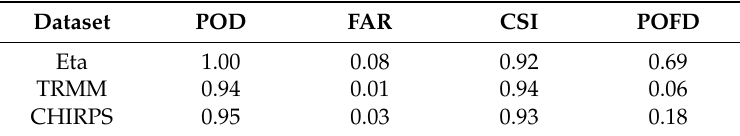
Table 5. Probability of Detection (POD), False Alarm Ratio (FAR), Critical Success Index (CSI), and Probability of false detection (POFD) for precipitation during the period from July 2009 to June